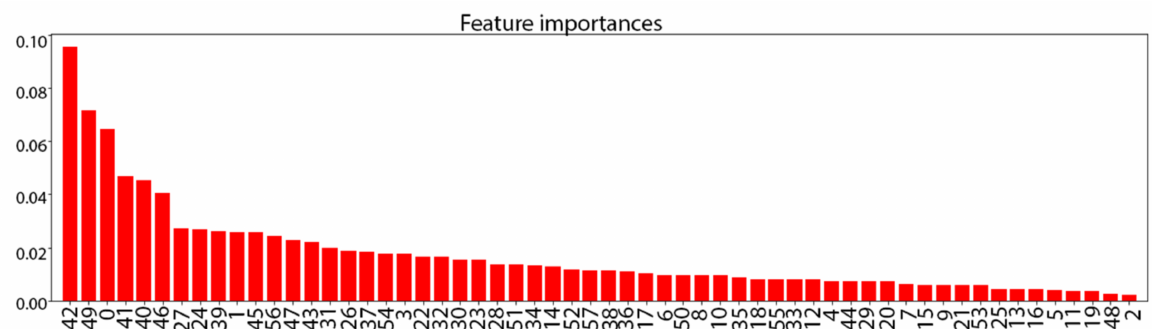
Figure A1. Feature importance for W-TSS shapelets in predicting indoor vs. outdoor time series PM 2.5 in PRISMS.